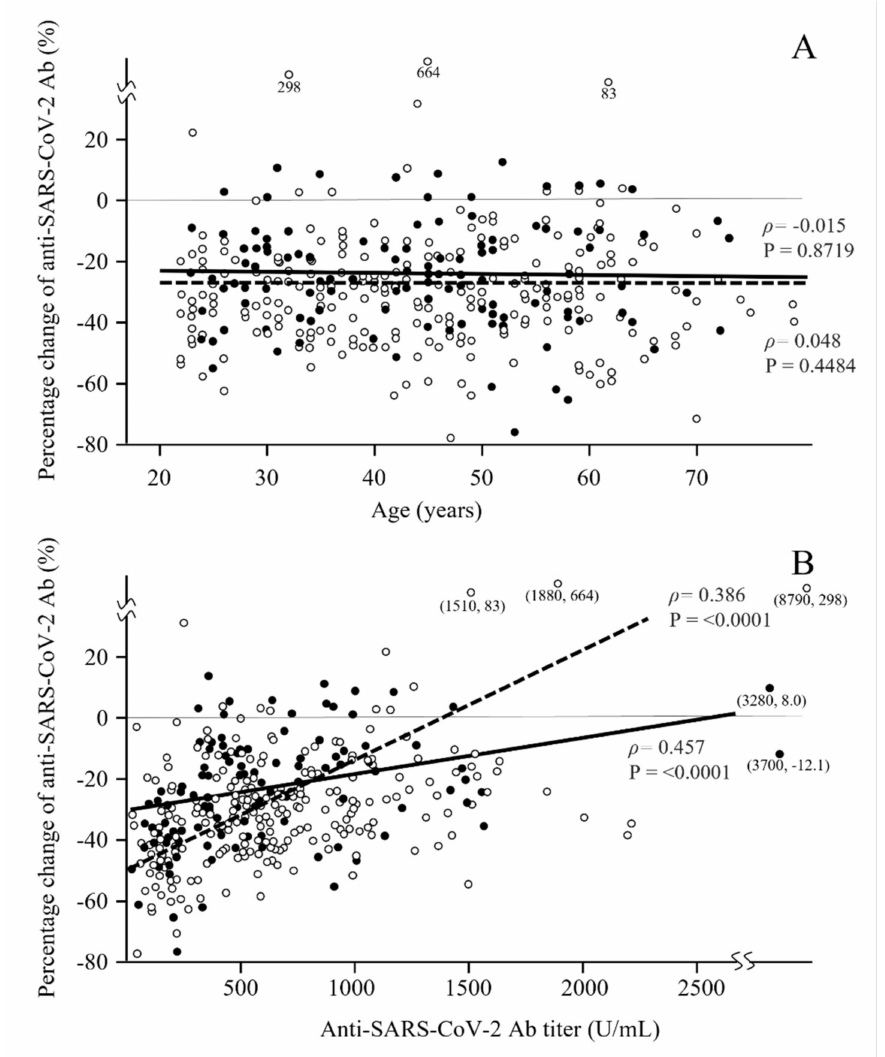
Figure 2. Scatter plot of the distribution of the percentage change in Ab titers from 3 to 6 months after the second dose of the vaccine according to sex. The relationship between the percentage change after the vaccination and age is shown in ( A ), and the relationship between the percentage change and the Ab titer 6 months after the vaccination is shown in ( B ). No significant correlation was observed in ( A ), and age did not affect the attenuation of the Ab titers from 3 to 6 months after the vaccination. However, a significant correlation was observed in ( B ). Closed and open circles and continuous and broken lines show men and women,